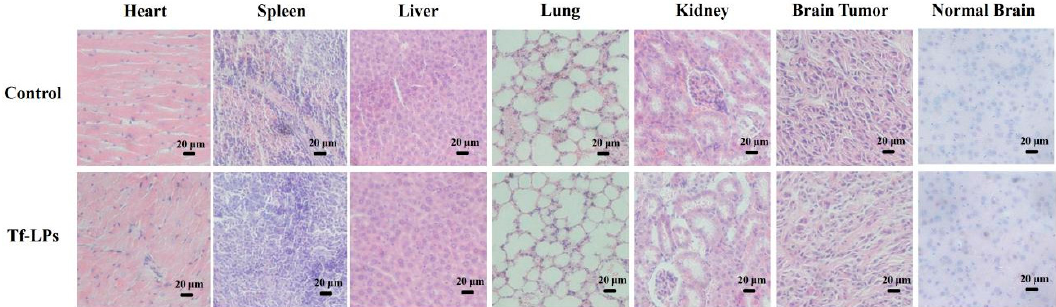
Figure 9. Histological analysis of mice treated with Tf-LPs. Tf-LPs treated mice showed no abnor- mality in organs examined, suggesting the safety of Tf-LPs. Abbreviations: LPs, DOX-loaded lipo- somes; Tf-LPs, DOX-loaded Tf-liposomes.